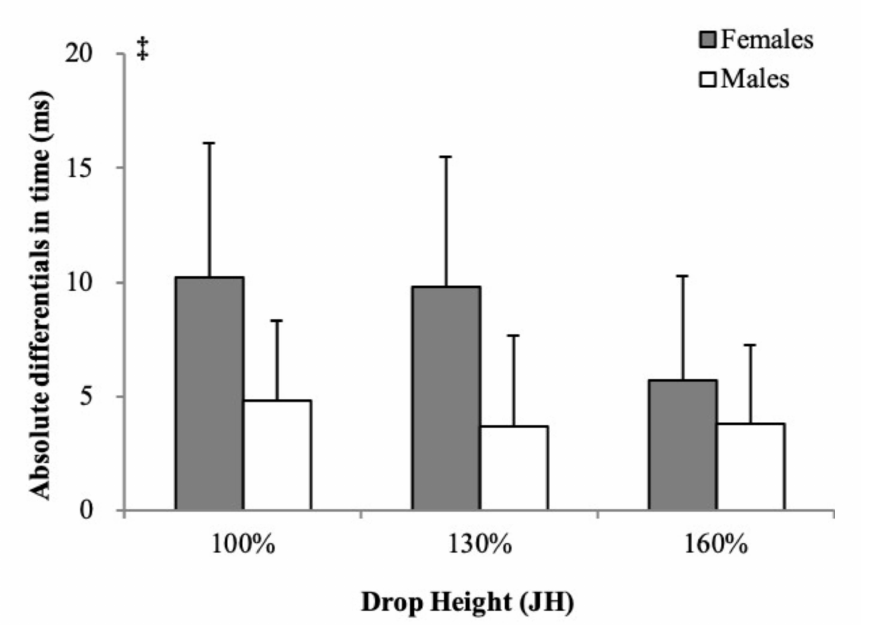
Figure 1. The side-to-side differentials in time of I-vGRFpeak between the dominant and nondom- inant limbs. I-vGRFpeak = peak impact force during the landing phase; JH = jump height of the countermovement jump. ‡ Significant sex main effect ( p <